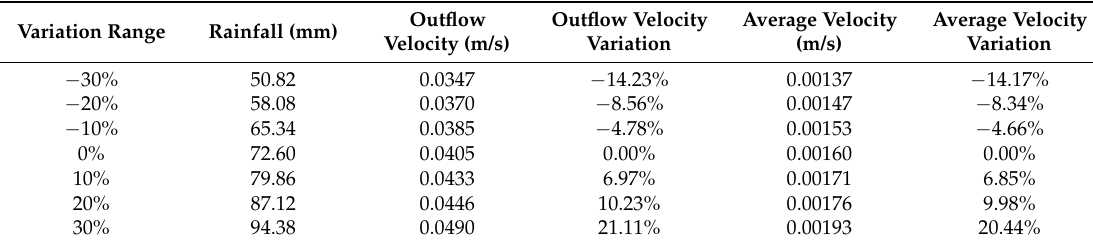
Table 4. Effect of rainfall on flow velocity.